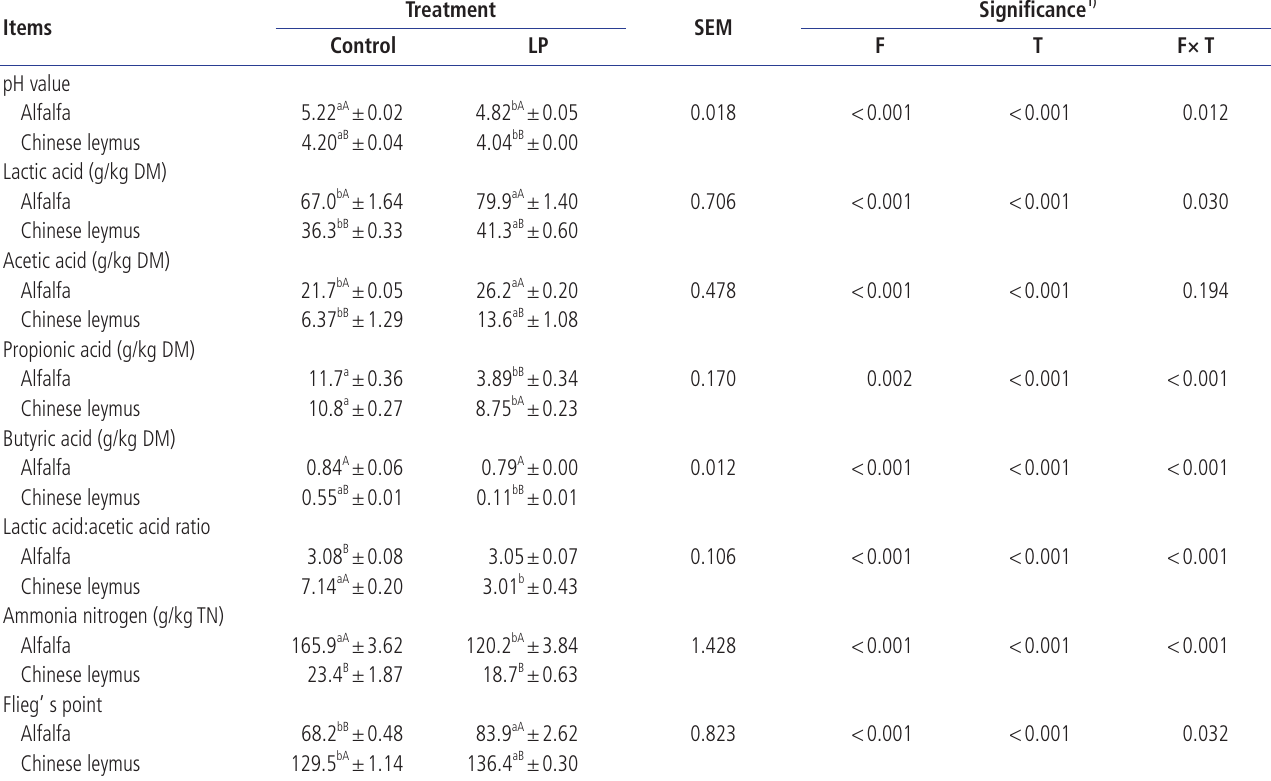
Table 2. Fermentation characteristics of alfalfa and Chinese leymus silages